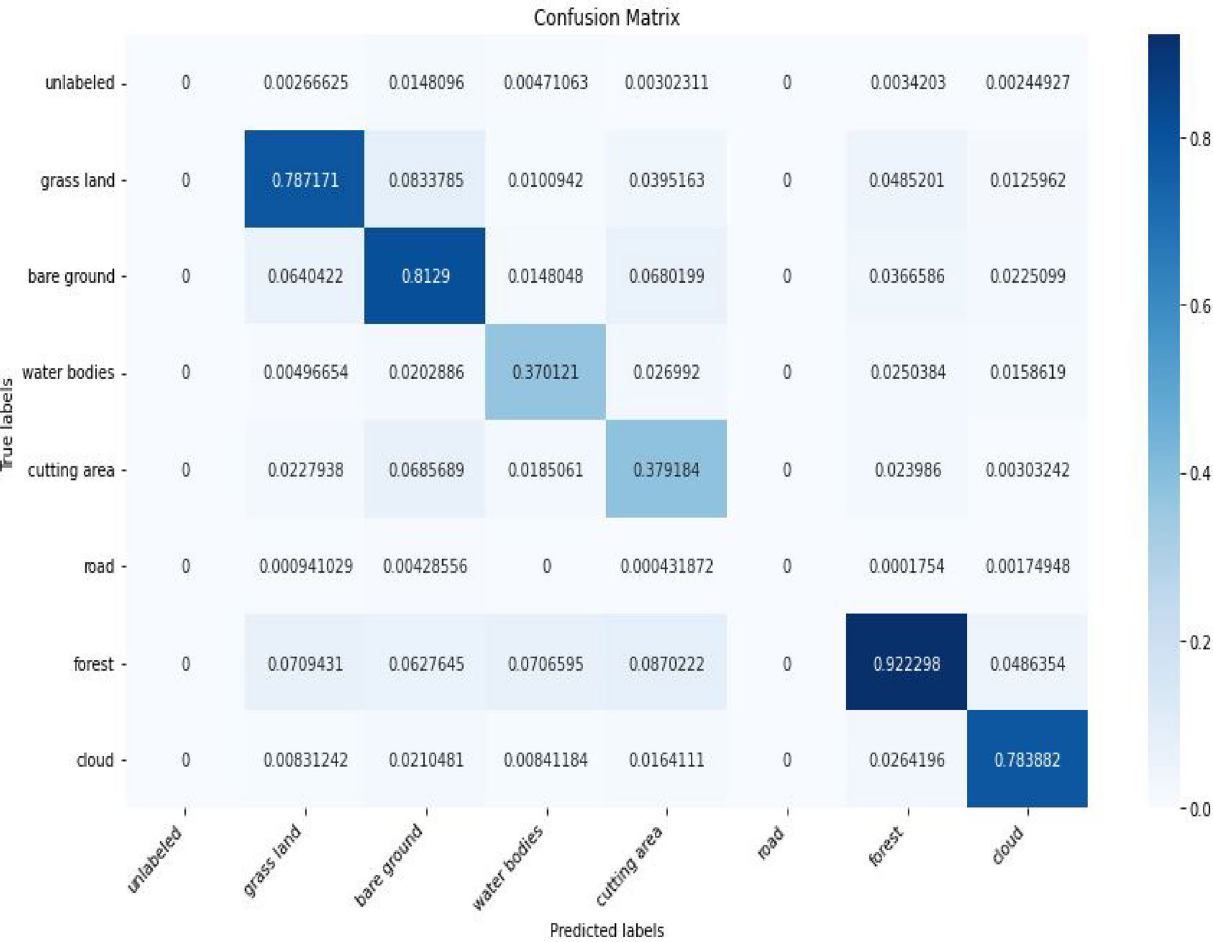
Fig. 5 Confusion matrix for CNN-SVM